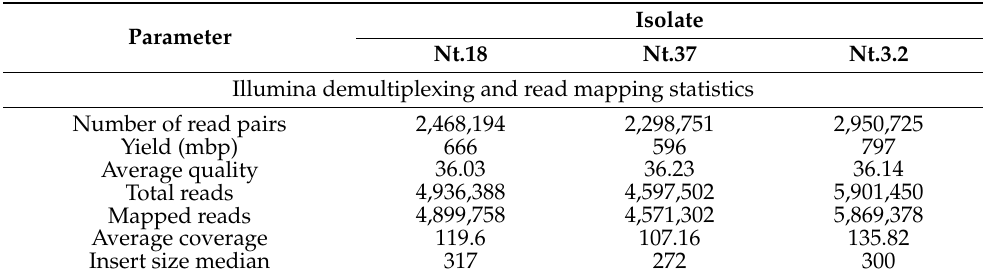
Table A2. Statistics of the bacterial isolate genome sequencing, de novo assembly, genome quality assessment, results of taxonomic assignment and